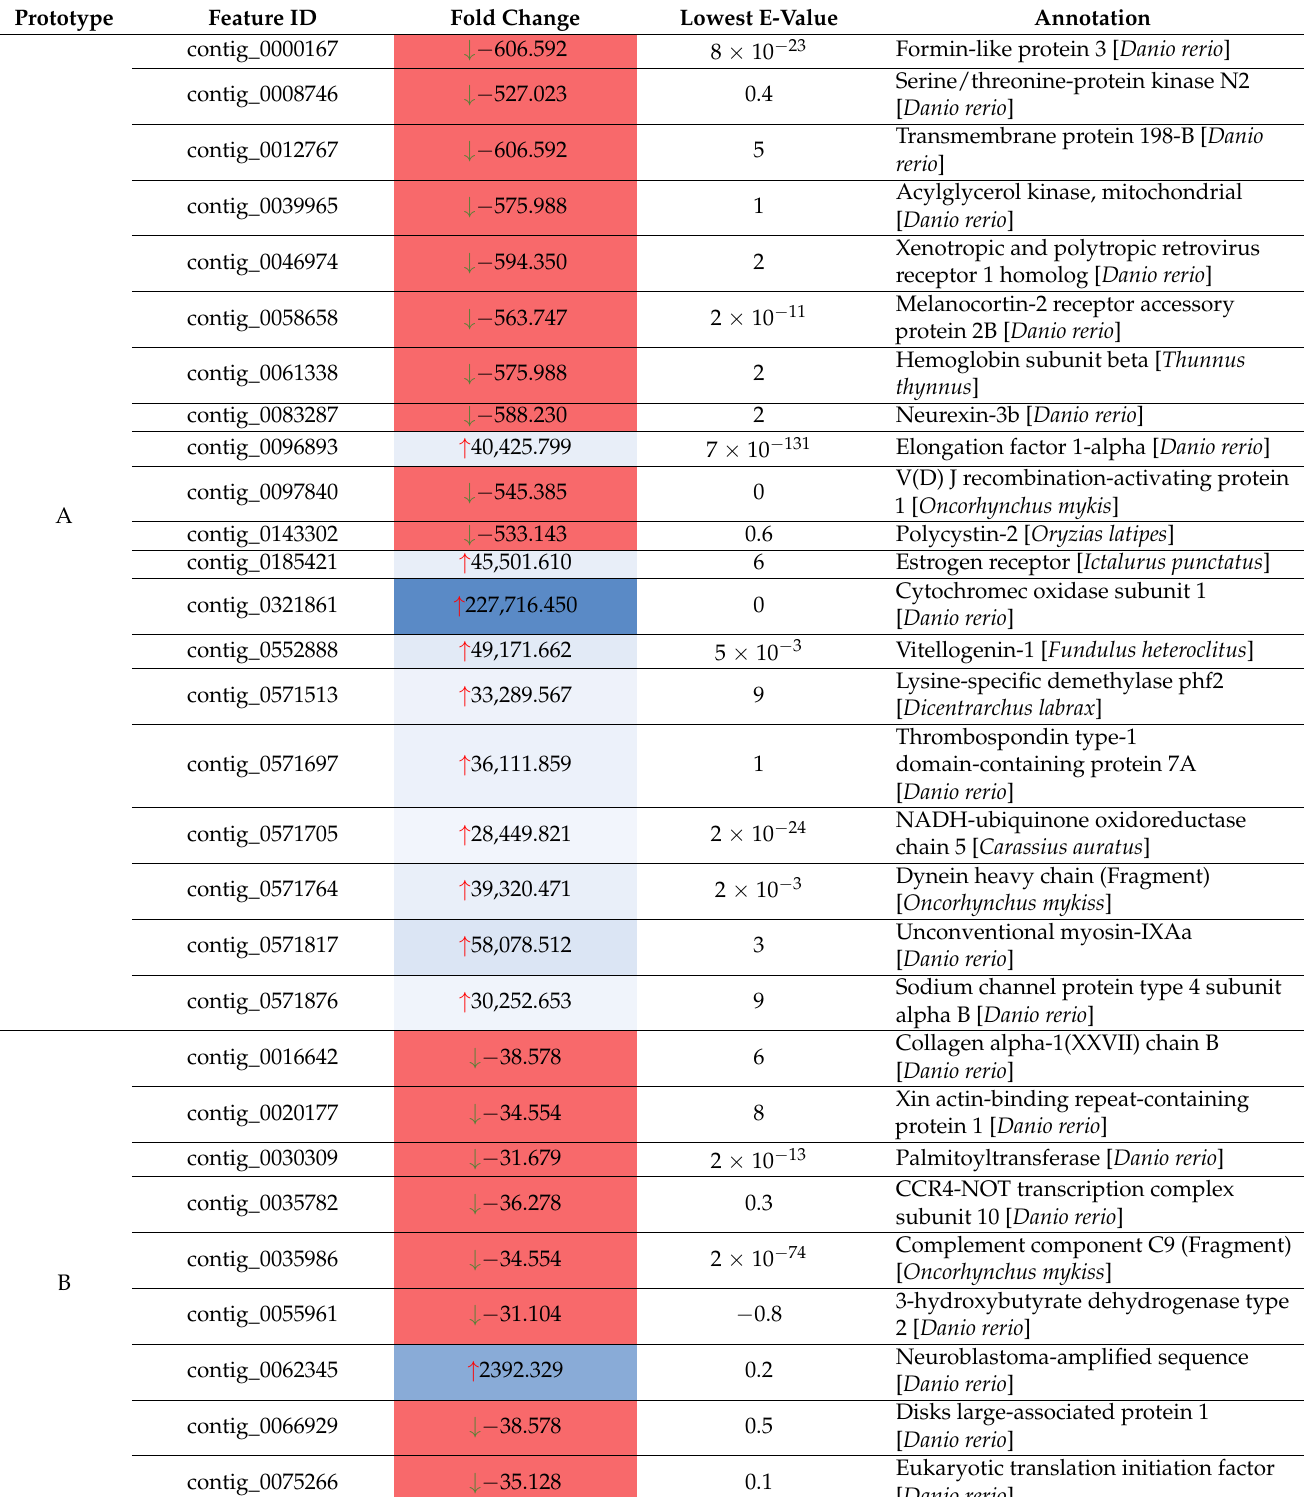
Table 2. Annotation of the differentially expressed contigs in skin tissue of vaccinated S. salar . Heatmap indicates the levels of regulation for each gene with blue at the top and red at the bottom. Red arrows indicate gene downregulation, and green arrows indicate